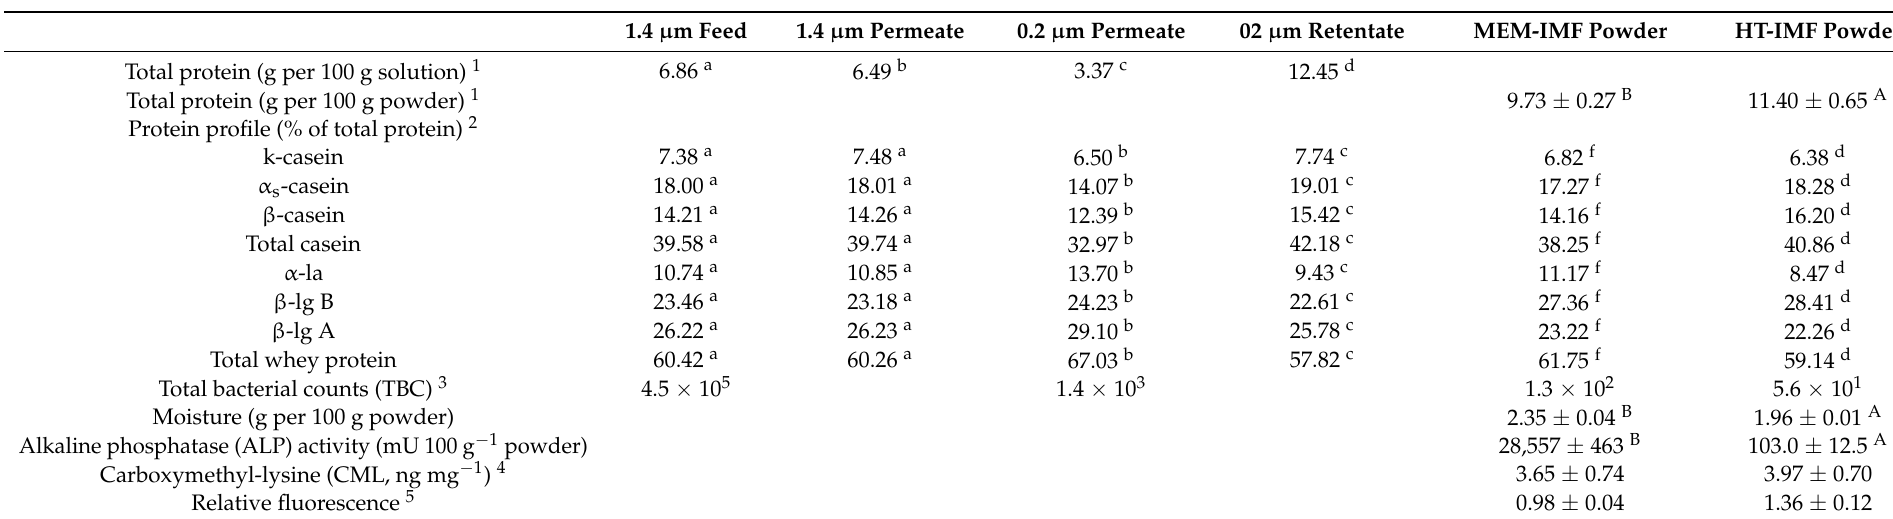
Table 3. Protein profile and quality analysis of MF feed, permeate, and retentate and final membrane-filtered infant milk formula (MEM-IMF) and high-heat-treated infant milk formula (HT-IMF)